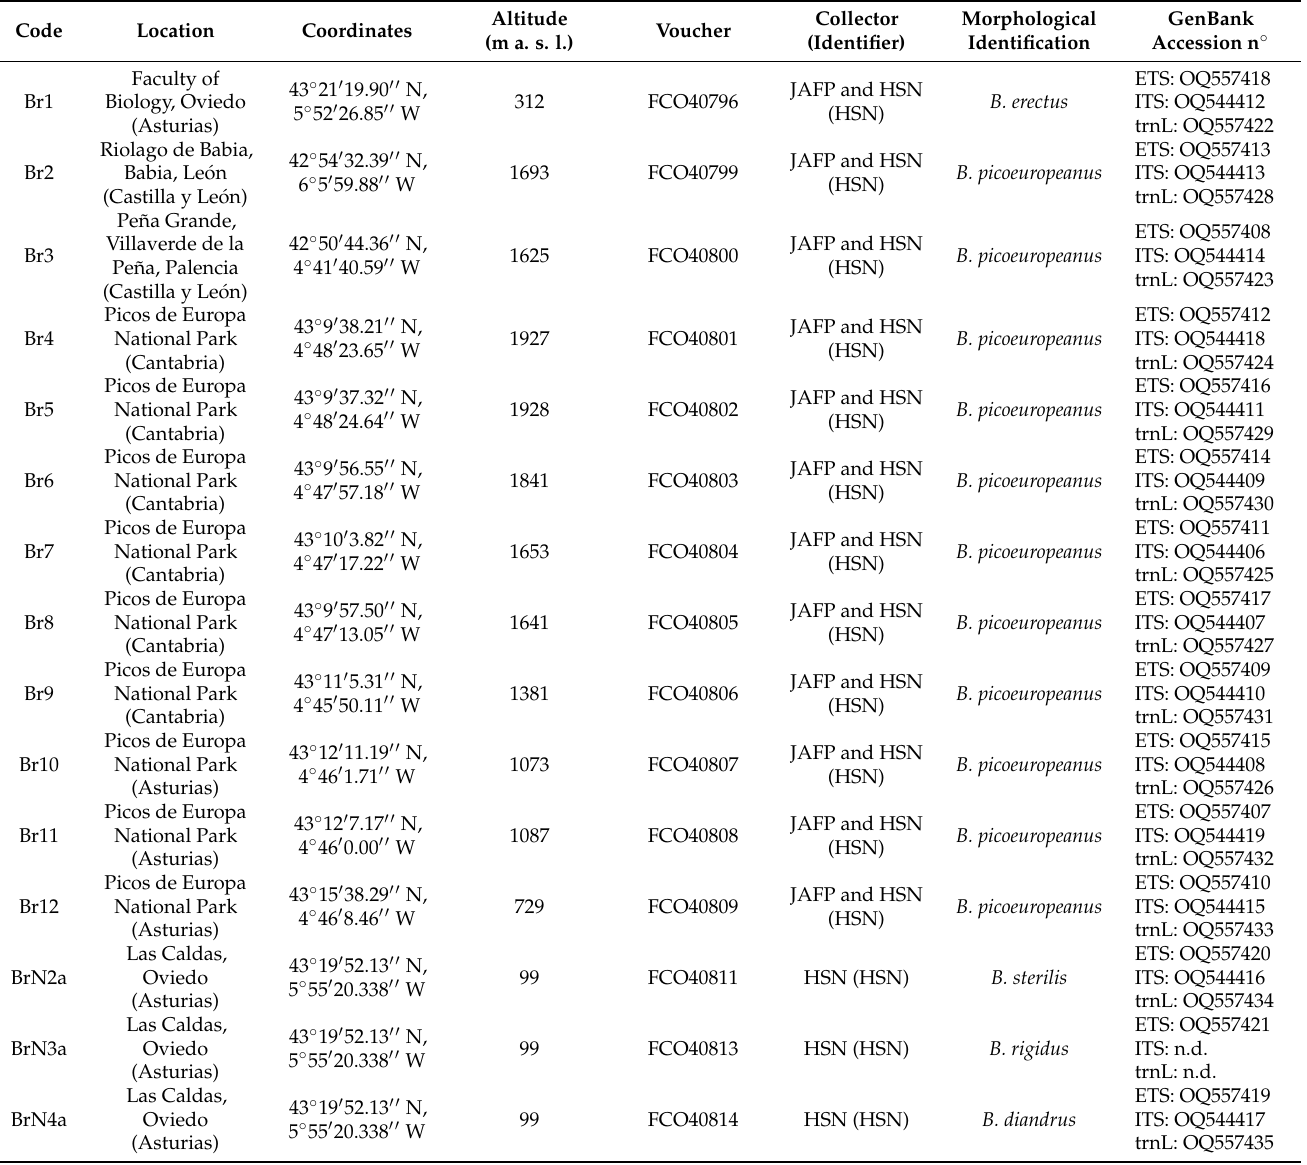
Table 2. Code of the samples used in this study, location of the sampled populations (coordinates), voucher, collector and identifier, the morphological identification flowing the given references